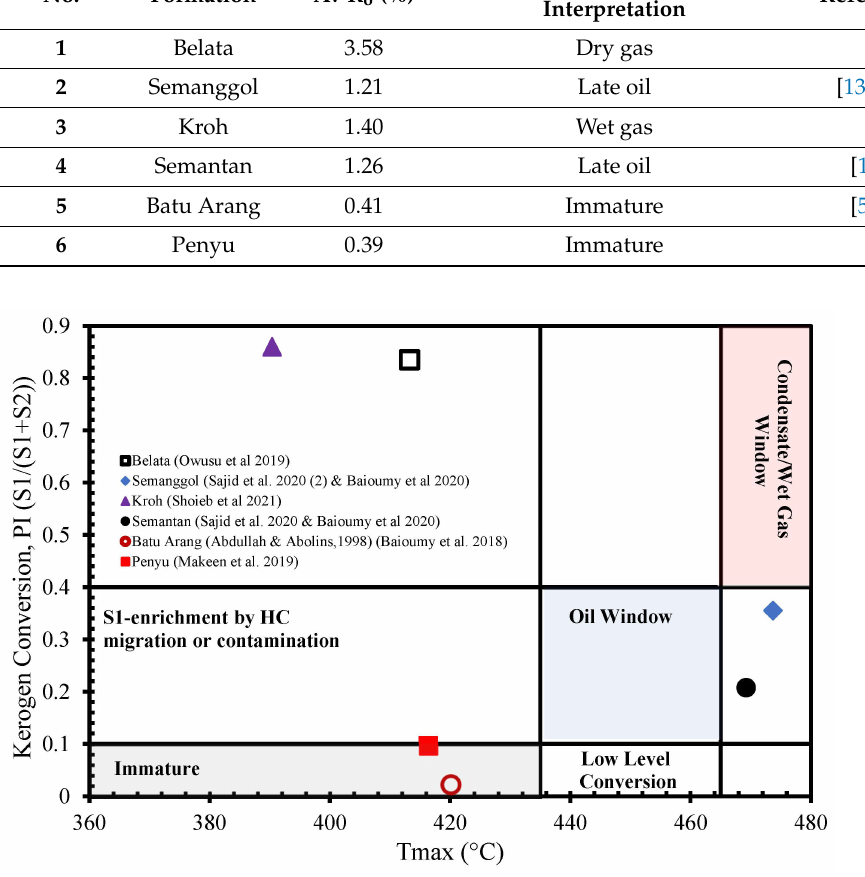
Figure 7. Tmax vs. PI plot showing level of kerogen maturity for formations in